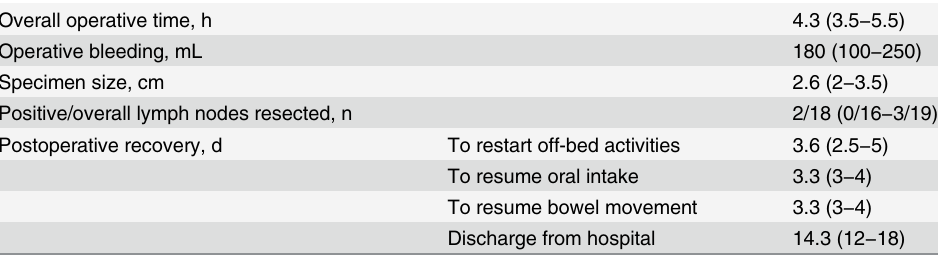
Table 2. Operative and postoperative recovery data.